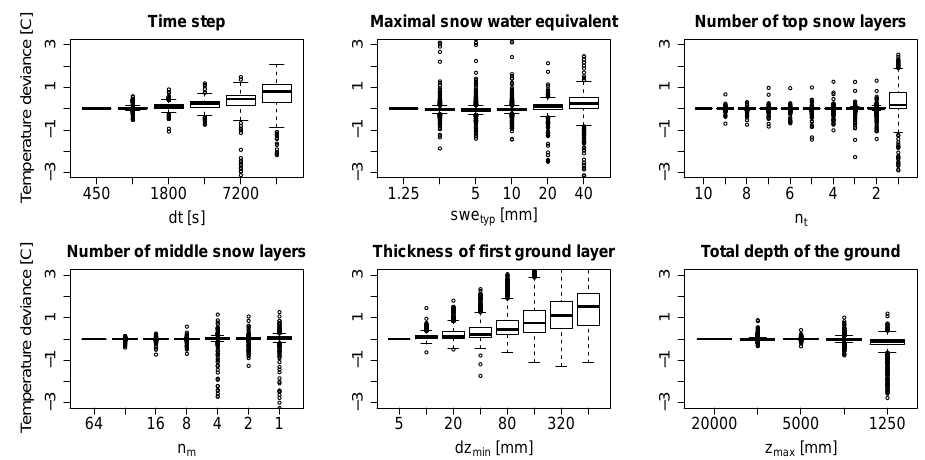
Fig. 8. Sensitivities of MAGT modeled at 1m depth to the six sensitive discretization parameters d t (top left), swe m (top middle), n t (top right), n m (bottom left), dz min (bottom middle) and z max (bottom right), normalized with MAGT modeled with the finest resolution of each parameter. The sensitivities are summarized as box plots for all topographic properties and the six ground types.